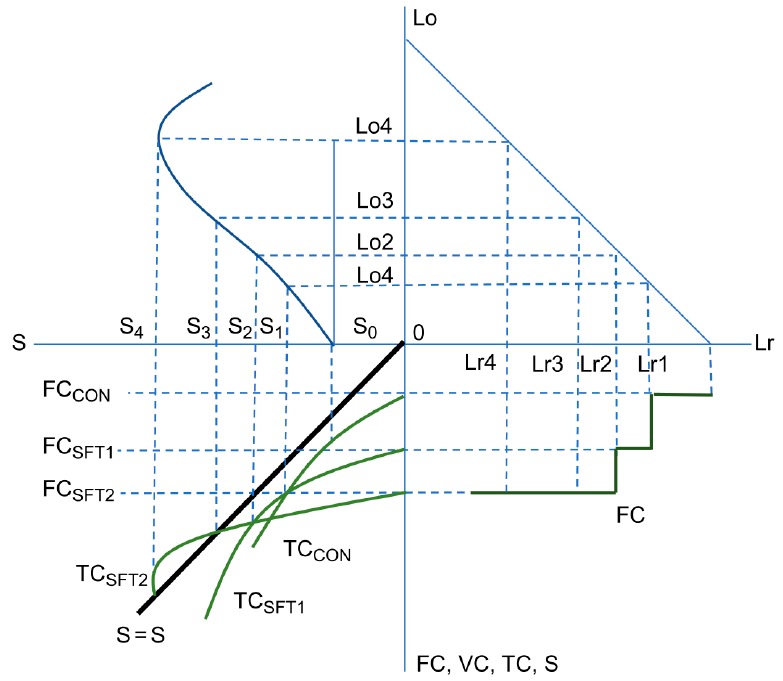
Figure 3. Theoretical model for introducing SFT by diversifying the business.